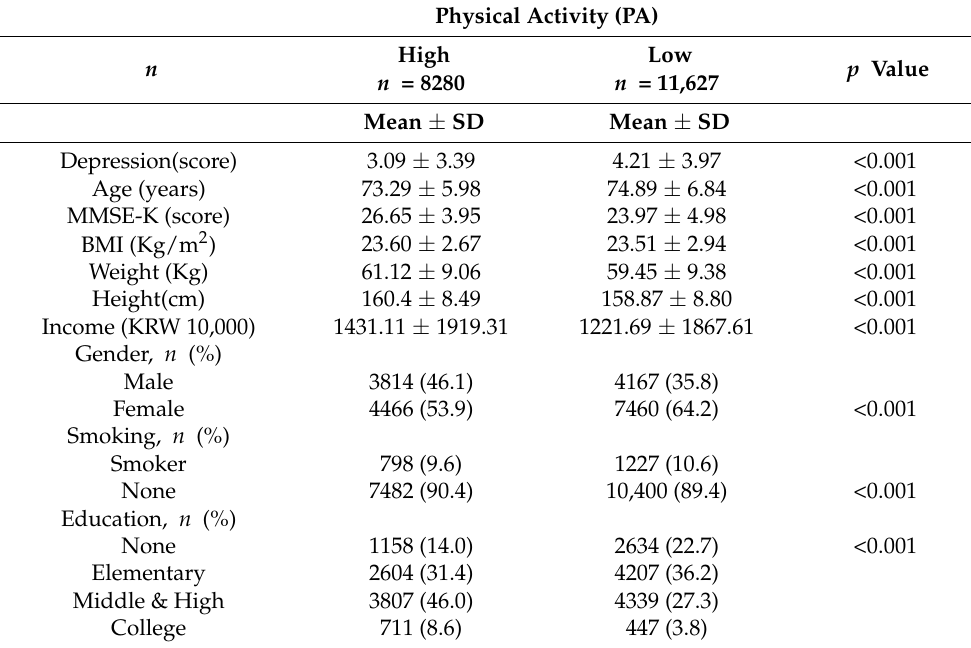
Table 2. Comparison of variables following physical activity.